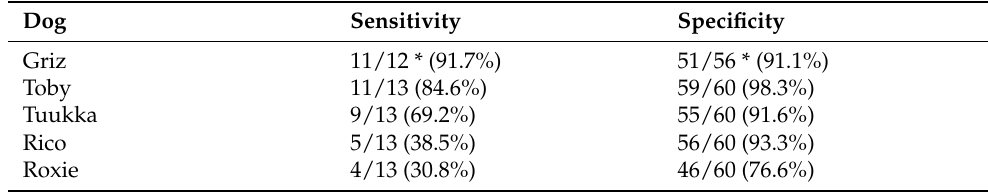
Table 5. Dogs’ sensitivity and specificity at test.